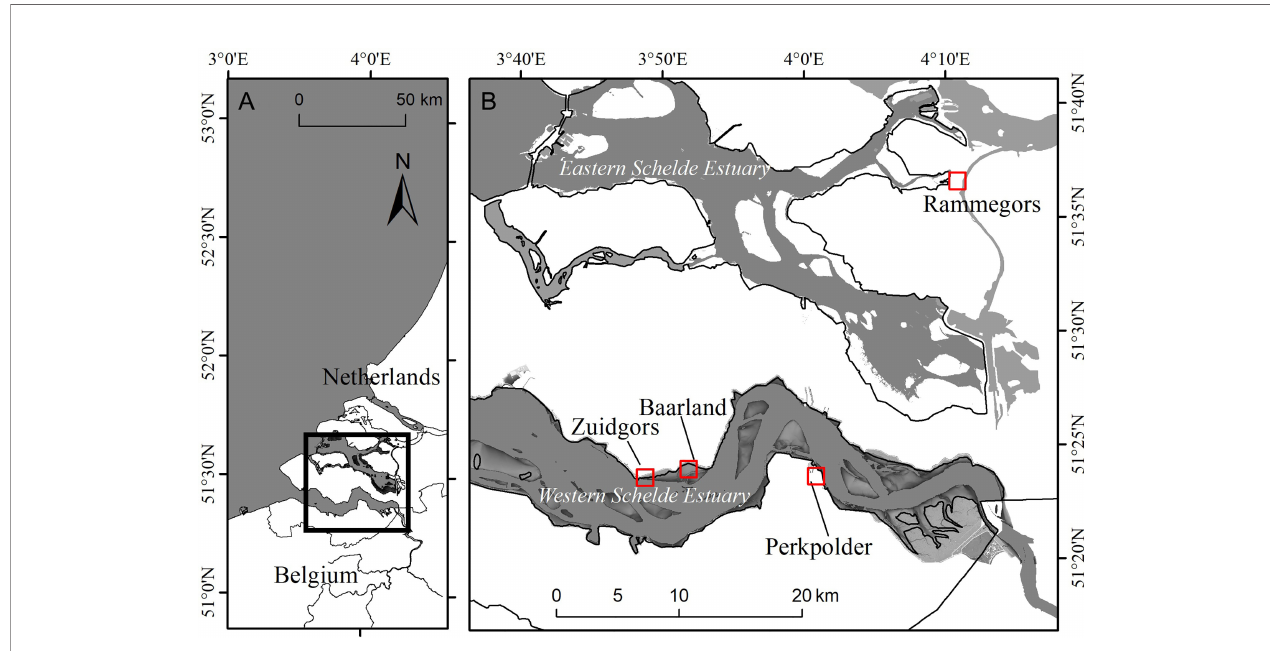
FIGURE 1 | (A) Location of the Scheldt Estuary, and (B) Location of Rammegors (Eastern Schelde Estuary) and Perkpolder (Western scheldt) for sediment collection in the mesocosm experiment, and fi eld study site of and Baarland and Zuidgors (both in the Western Scheldt estuary) for measuring sediment